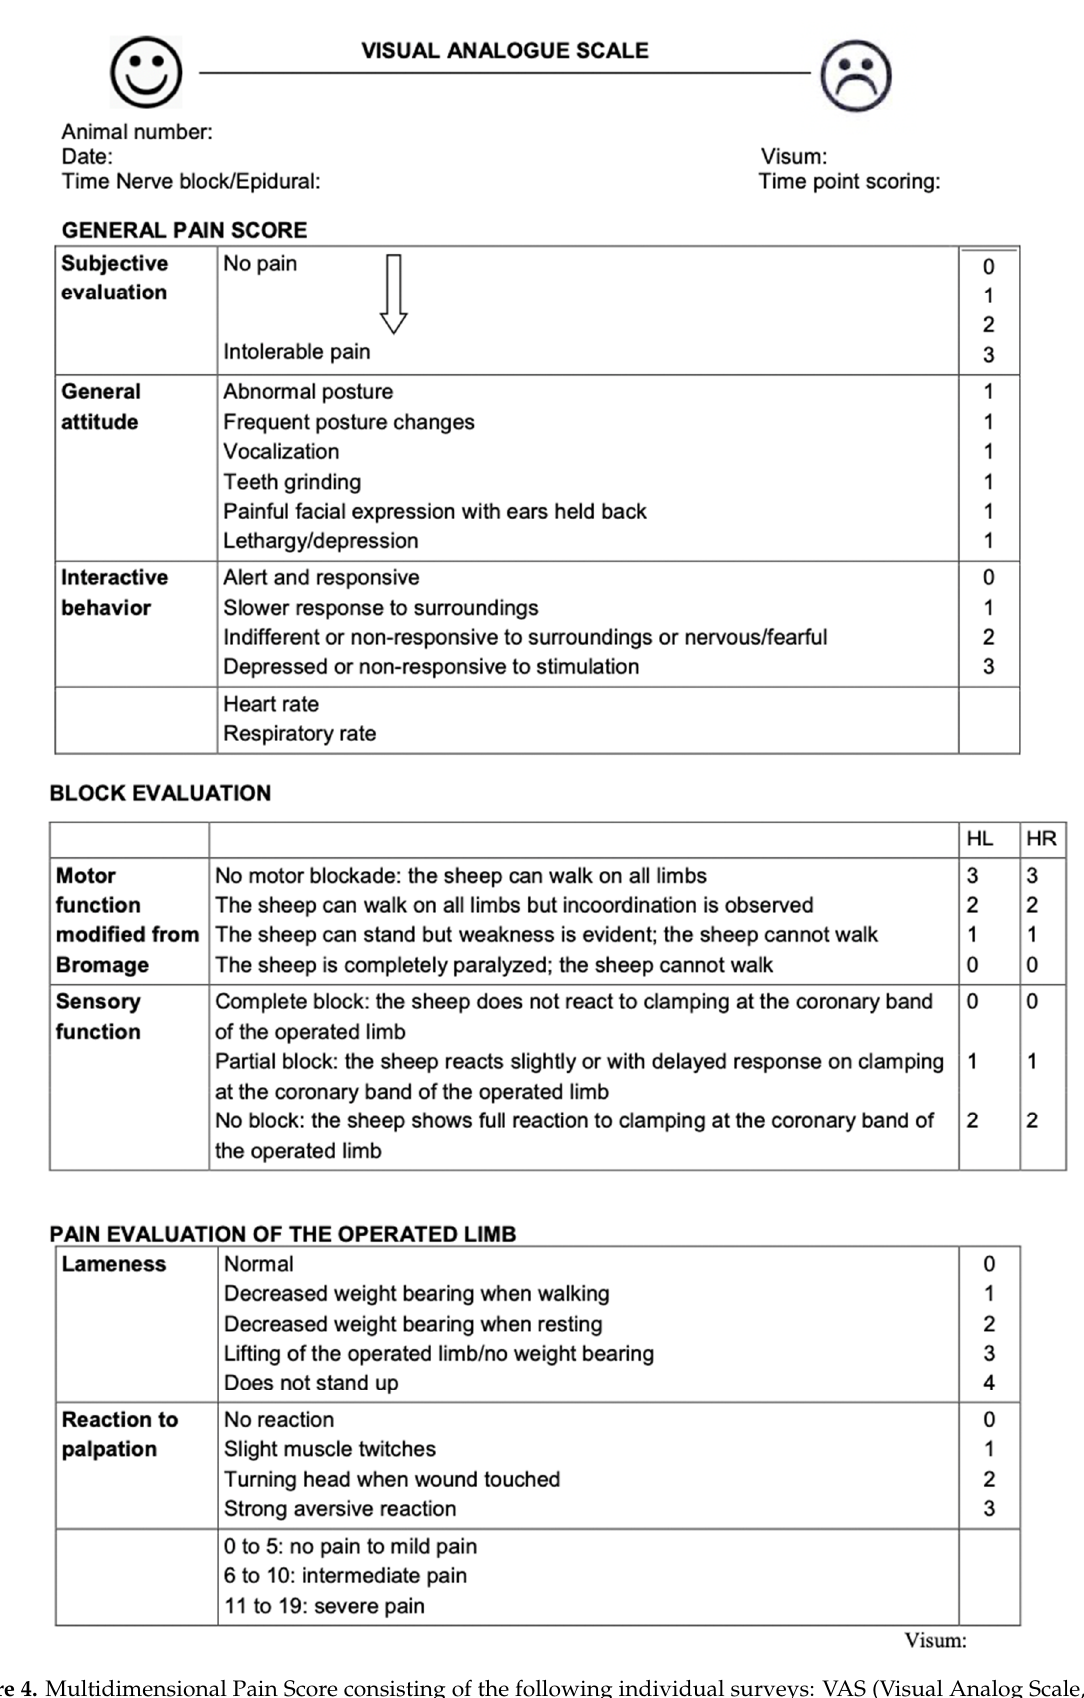
Figure 4. Multidimensional Pain Score consisting of the following individual surveys: VAS (Visual Analog Scale, 10 cm horizontal line), general pain score, block evaluation score and pain evaluation score of the operated limb.